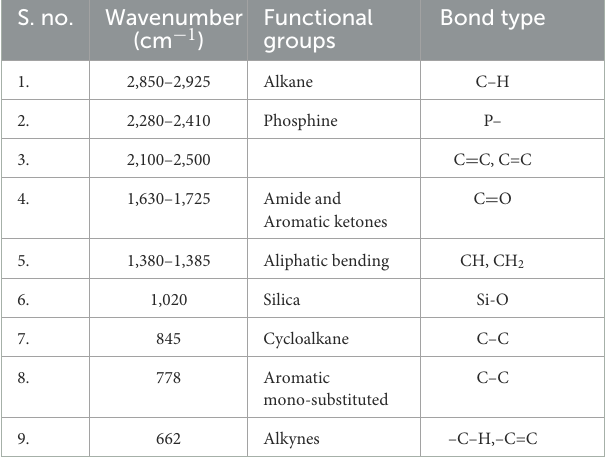
TABLE 1 List of band assignments for Fourier transform infrared (FTIR)